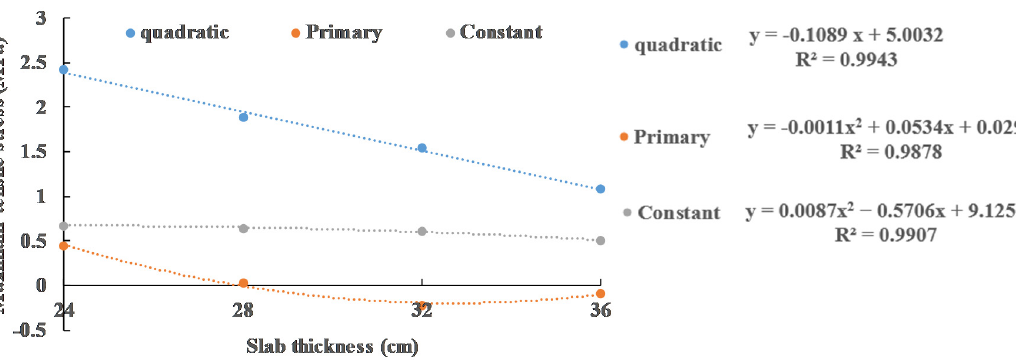
Table 3. Comparison between simulation results and function calculation results.